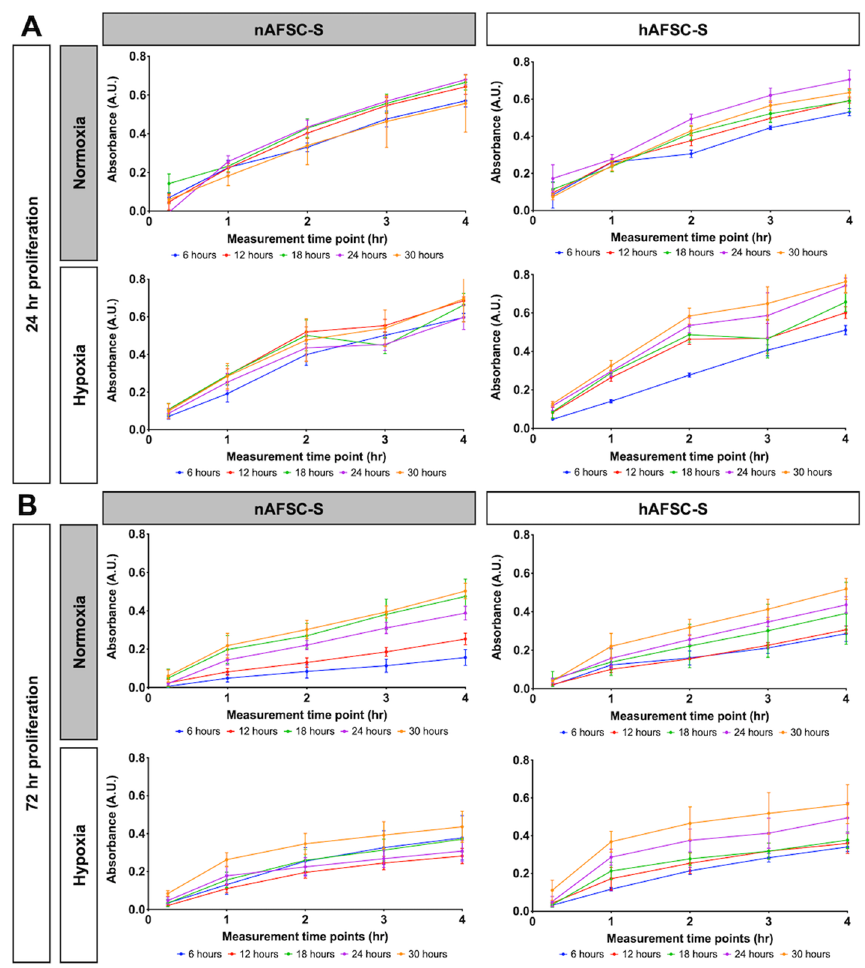
Figure 3. Evaluation of the temporal growth curve of human cardiomyocytes (hCM). Comparison of the MTS tetrazolium compound reduction in a colorimetric assay to asses proliferation of hCM cultured for ( A ) 24 h (24 h proliferation) and ( B ) 72 h (72 h proliferation) in 21% O 2 (Normoxia) and 1% O 2 (Hypoxia) culture conditions with normoxic (nAFSC-S) or hypoxic (hAFSC-S) amniotic fluid stem cells secretome collected at 6 (blue), 12 (red), 18 (green), 24 (purple) and 30 h (orange). The first absorbance (A.U.) measurement was recorded at 15 min and then subsequently at 1, 2, 3 and 4 h. Date are expressed as means ± SD. n =